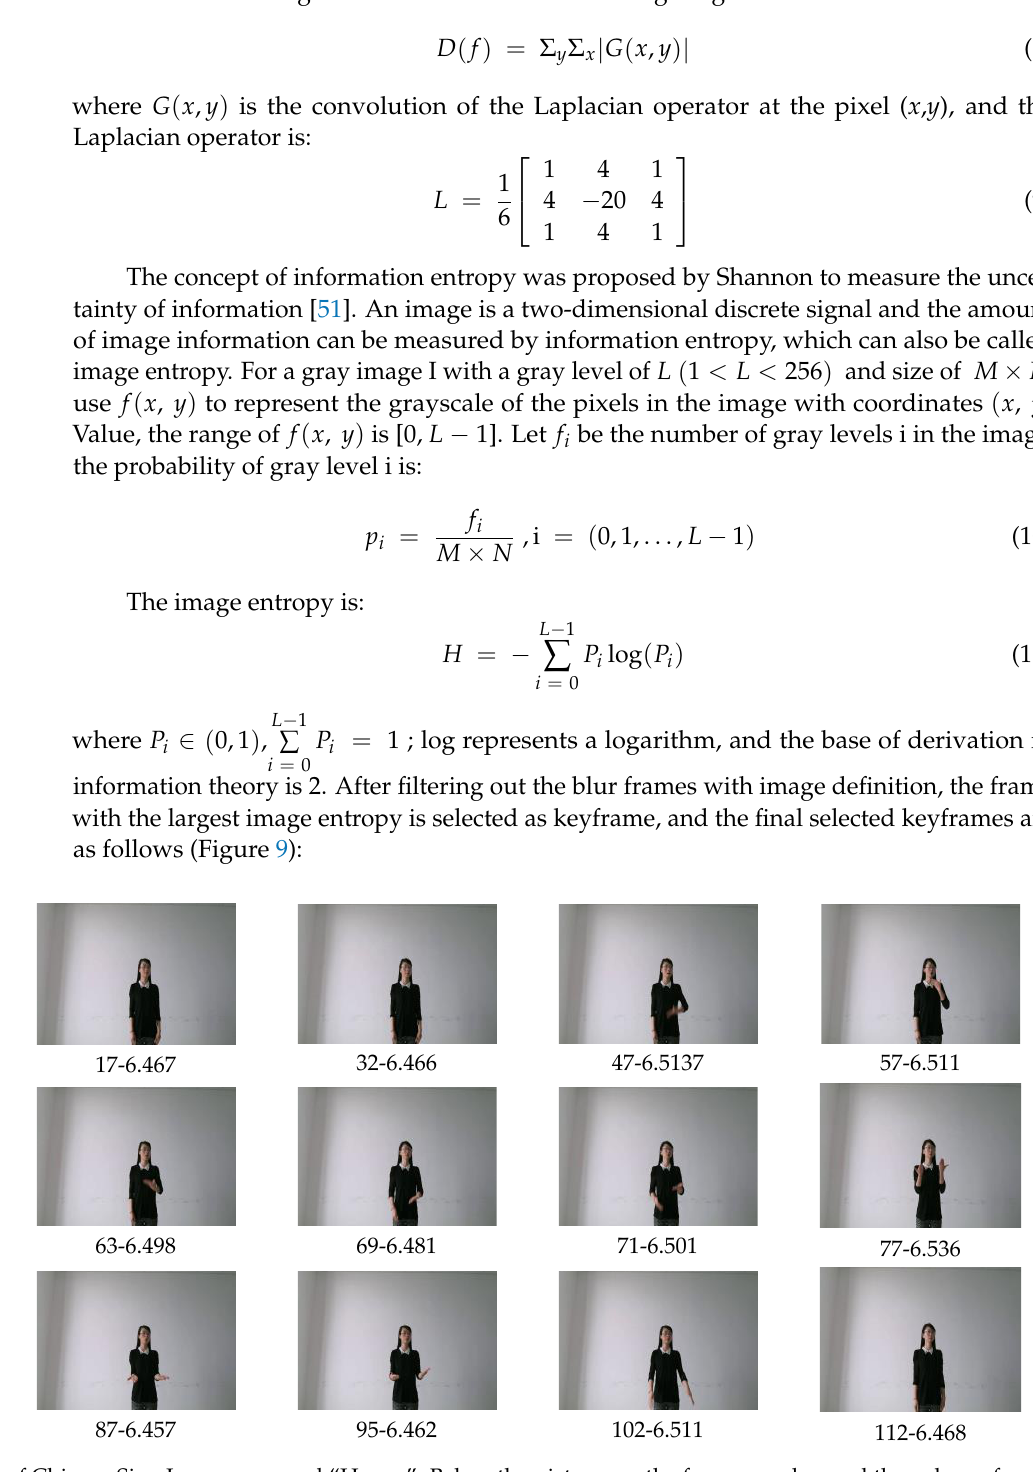
Figure 9. Keyframes of Chinese Sign Language word “Heavy”. Below the picture are the frame number and the values of image entropy. For example, 4-6.476 means the frame number is 4, and the image entropy is 6.476.